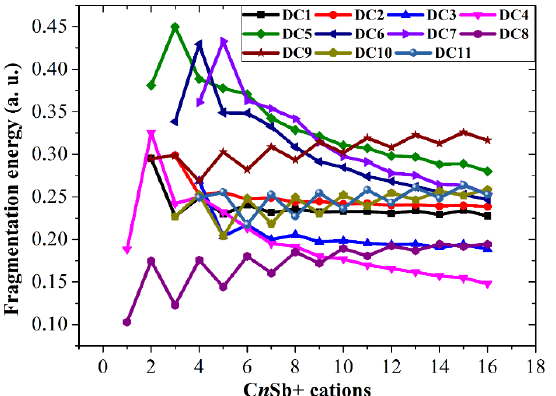
Figure 16. Fragmentation energies of C n Sb + cations. DC x corresponds to different dissociation channels, as shown in the text.